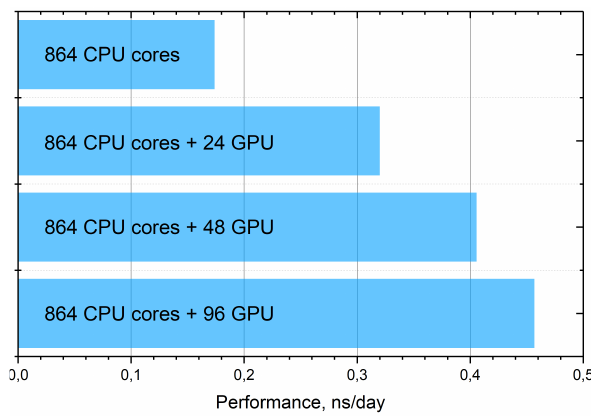
Figure 11: Performances for different configurations of 24 GPU- nodes: 0, 1, 2, and 4 GPUs per node